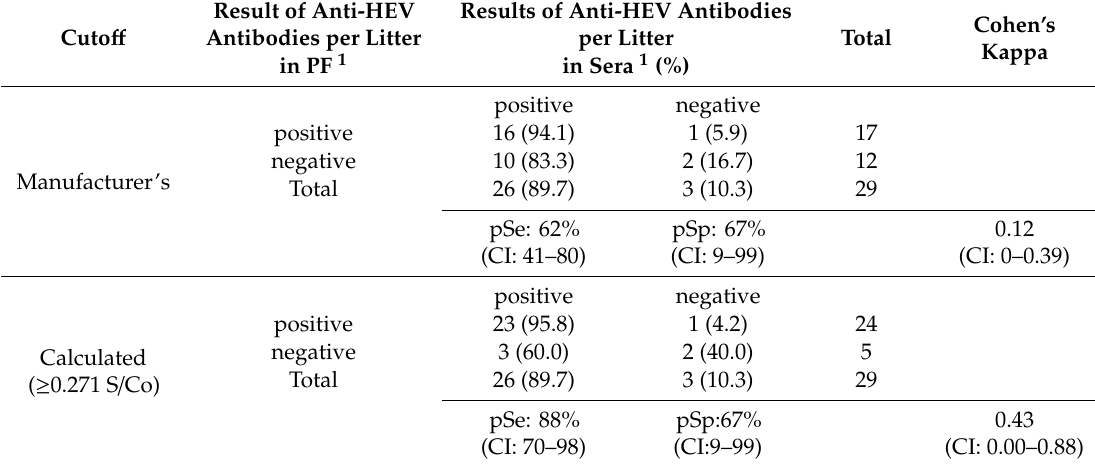
Table 3. Agreement between processing fluids (PF) and sera-based HEV ELISA results at the litter level.